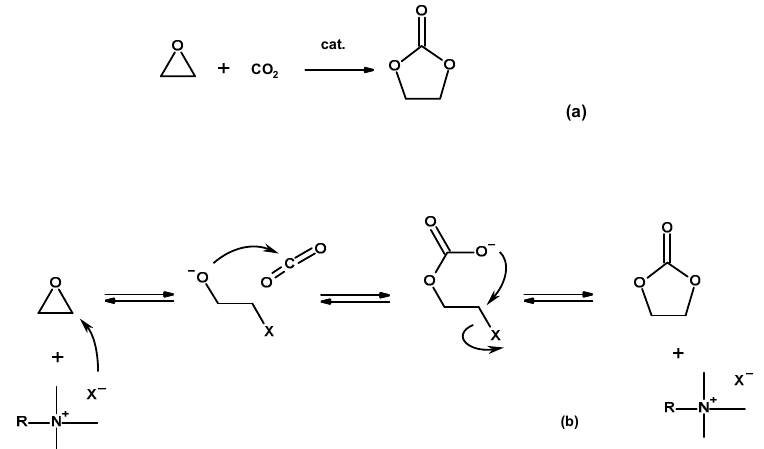
Table 7. The amounts of reagents and reaction yields for carbon dioxide addition to oxirane. Catalyst Cat. / anion